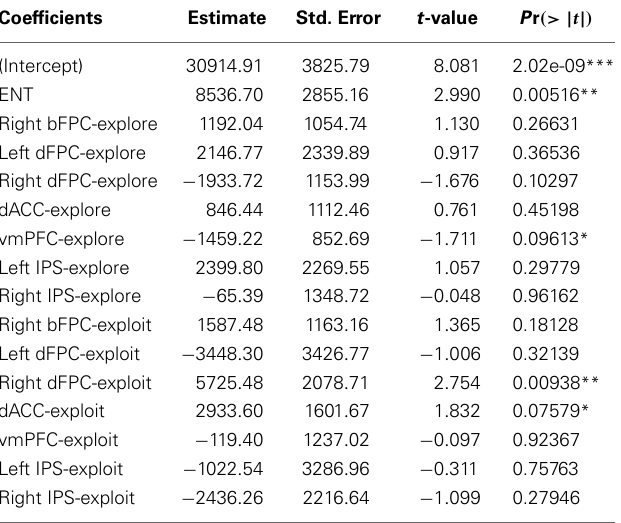
Table 5 | Multiple regression coefficients and statistics.